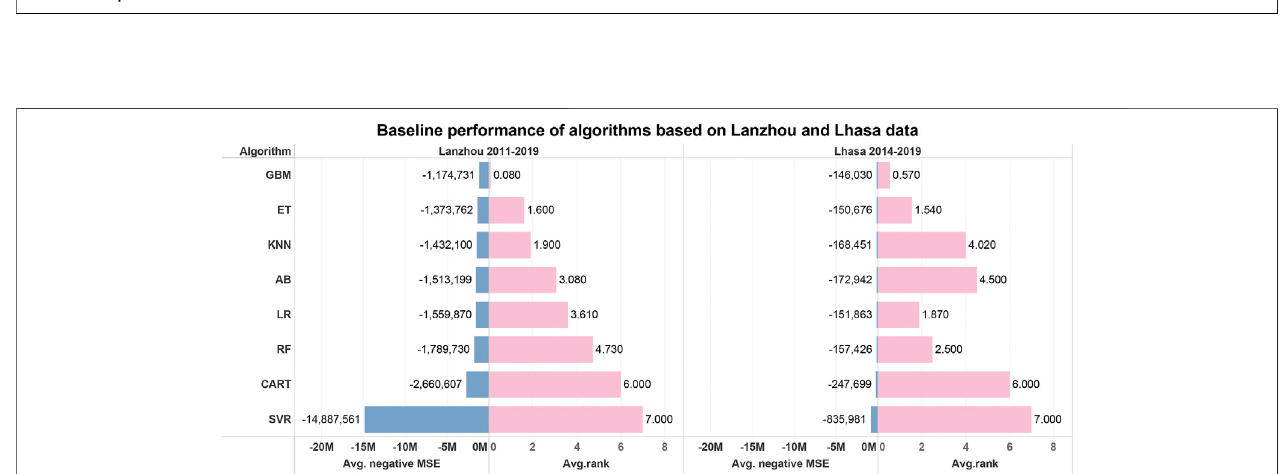
FIGURE 2 | Results of algorithm selection for estimating Lanzhou and Lhasa residential electricity consumption (REC). Blue bars indicate negative mean squared error (MSE) and pink bars indicate the average ranking for each algorithm based on 100 runs. Shorter bars indicate a better baseline performance of the corresponding algorithm (GBM - gradient boosting machine, ET - extra trees, KNN - k-nearest neighbors, AB- adaptive boosting, RF - random forest, CART - classi fi cation and regression tree, SVR - support vector regression, LR - simple linear regression model, i.e., the ordinary least squares (OLS) model).